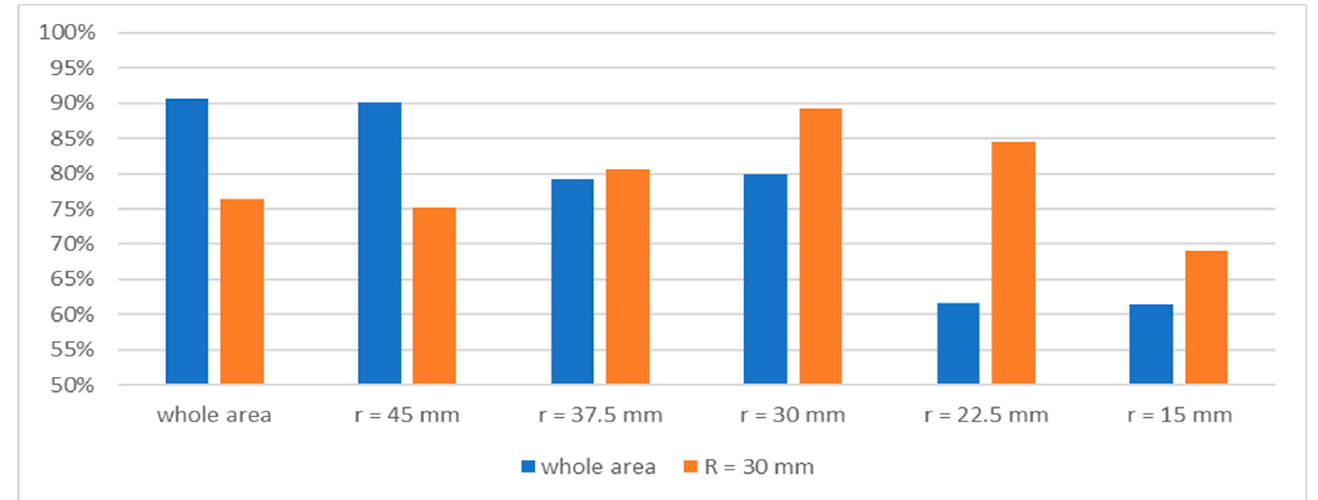
Figure 8. The share of correctly classified markers for the entire pattern and in the area with radius R = 30 mm around the center of the marker grid, depending on the adaptation function (the size of the assessed area around the center of the images) for 400 individuals.